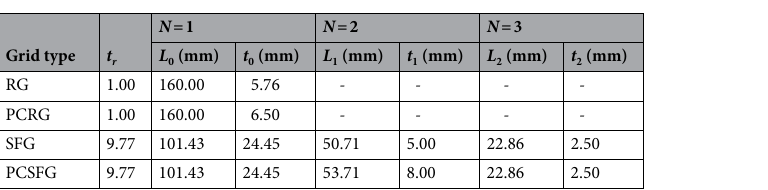
Figure 1. Schematic diagram of 2D planar space-filling gird of ( a ) RG, ( b ) SFG, ( c ) PCRG, ( d ) PCSFG, ( e ) geometrical representation of wind tunnel test section with tracer particle attached on square frame and ( f ) seven T -type thermocouple locations on the plate-fin heat sink.